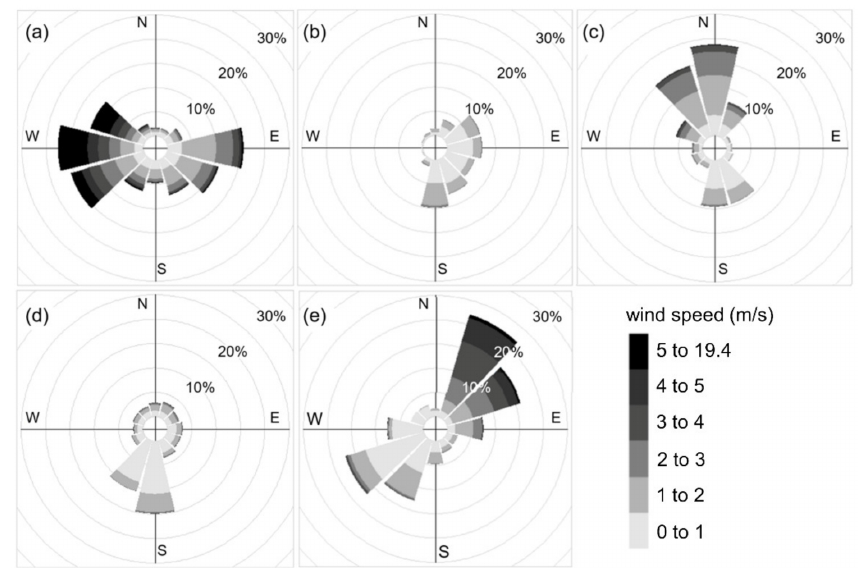
Figure 8. Overview of wind directions and wind speeds during the sampling campaign 2020 (1 April to 3 June or 1 July for UFS) at ( a ) UFS, ( b ) Kreuzeck, ( c ) Hausberg, ( d ) Eibsee and ( e ) DWD.